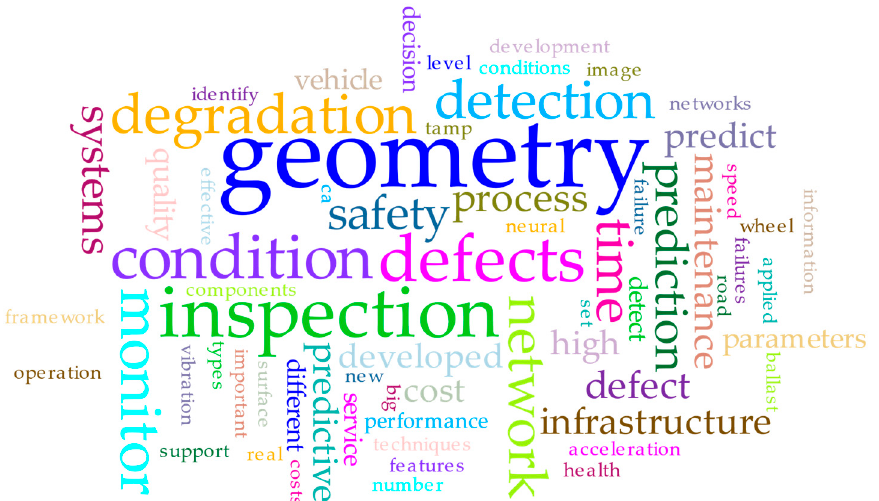
Figure 2. Word frequency distribution for the paper titles and abstracts.